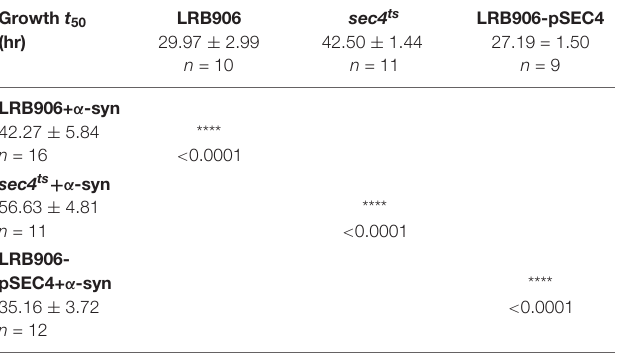
TABLE 2 | Growth of LRB906 yeast strains.